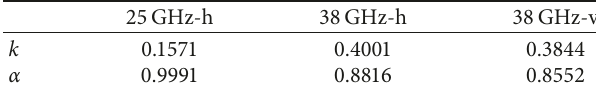
Table 6: Values of k and α (ITU model).